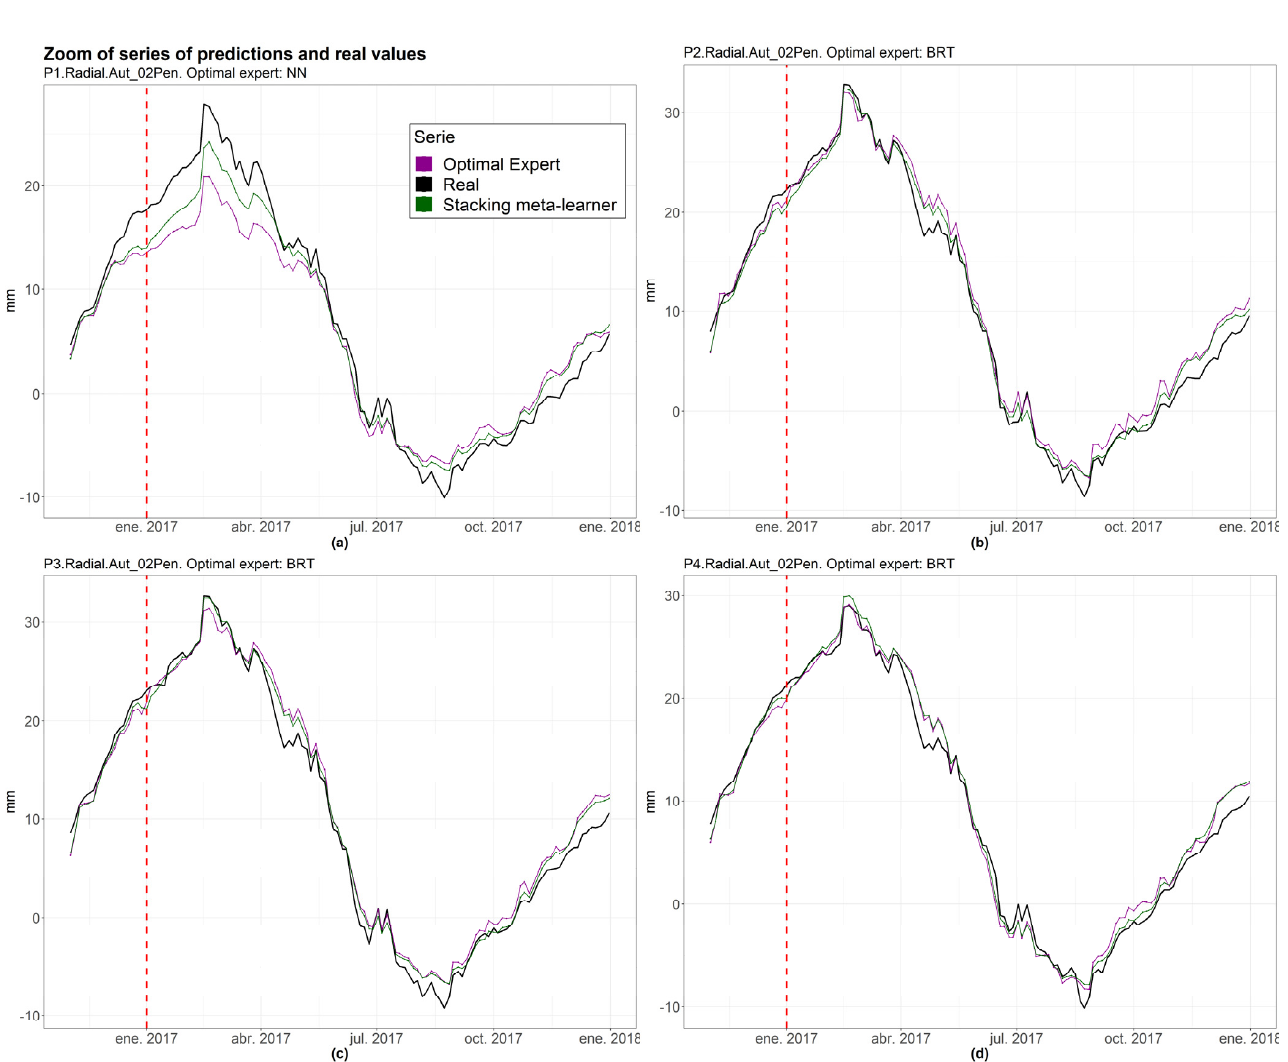
Figure 11. Zoom series of the optimal expert, the real value and the Stacking meta-learner. The red dashed line indicates the first date of validation. ( a ) Zoom series of pendulum 1; ( b ) Zoom series of pendulum 2; ( c ) Zoom series of pendulum 3; ( d ) Zoom series of pendulum 4.